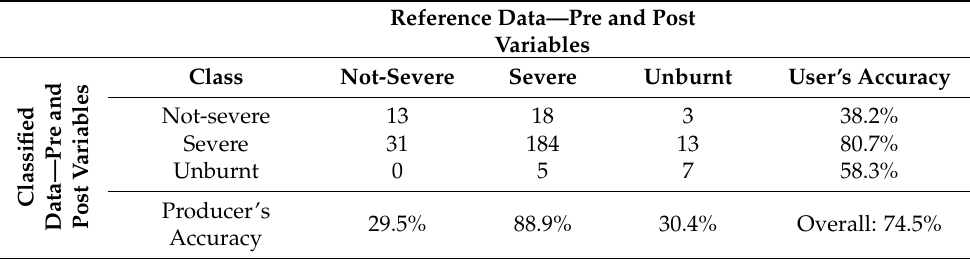
Table 12. Confusion matrix for LiDAR-only stream describing severity of forest segments.